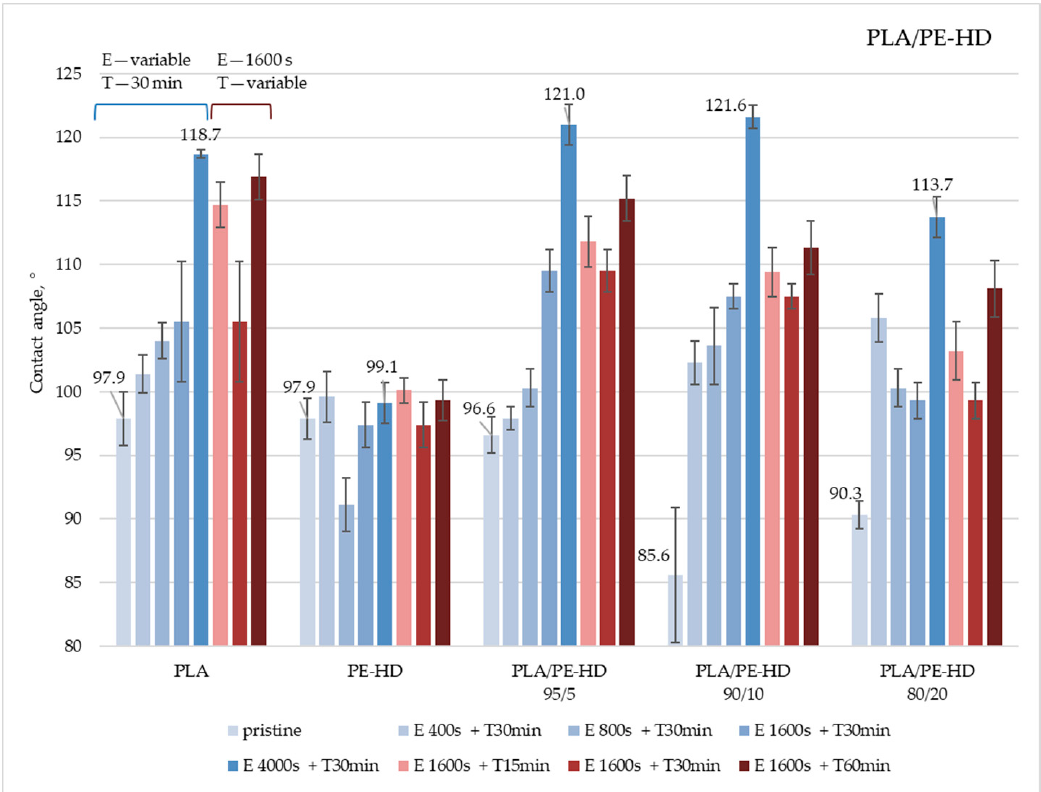
Figure 4. Water contact angles on PLA/high-density polyethylene (PE-HD) polymer blends treated under different etching and coating conditions (E—etching; T—CF x coating)